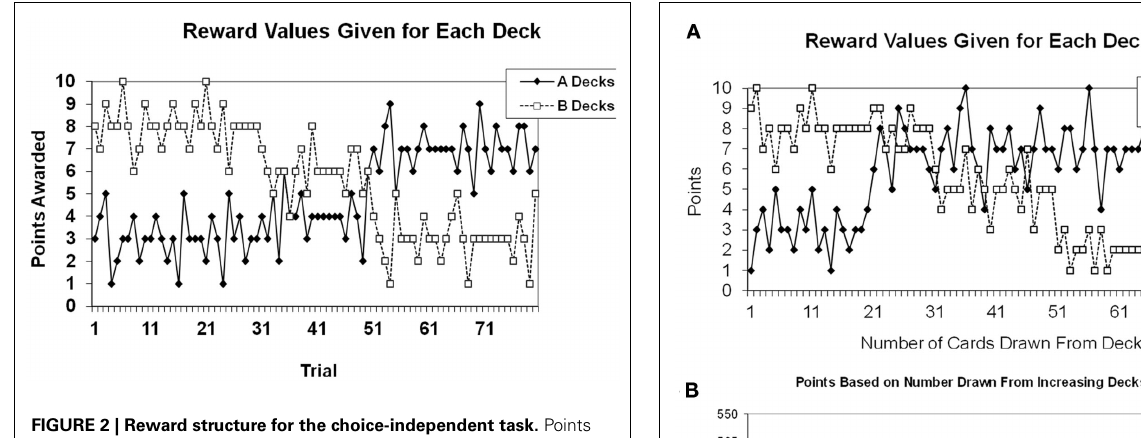
FIGURE 2 | Reward structure for the choice-independent task. Points given were based on the trial number, rather than participants’ previous behavior.